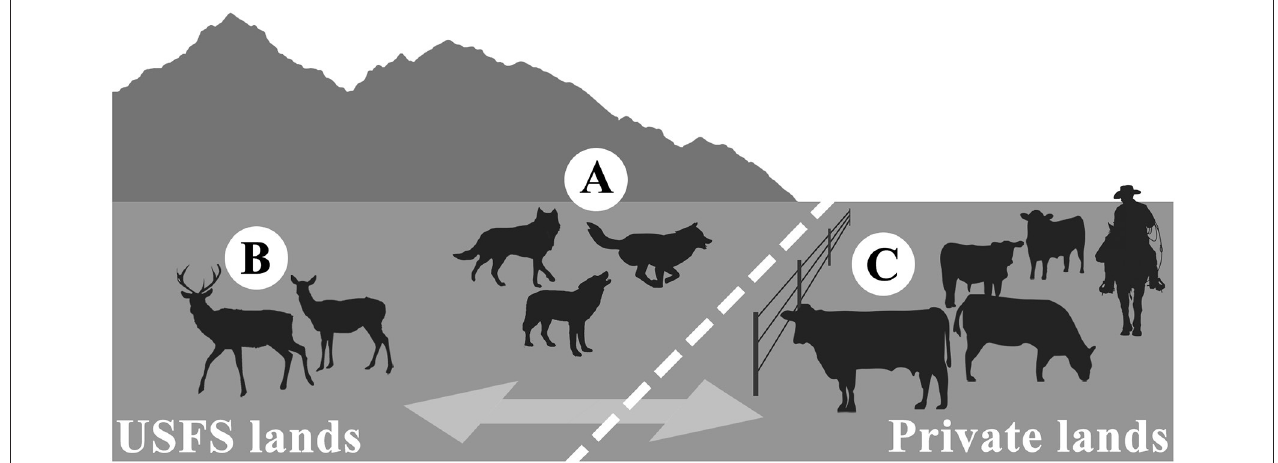
FIGURE 1 | Managing animals across jurisdictions. Livestock producers (“permittees”) graze privately-owned sheep and cattle on private lands as well as seasonally on USFS allotments, where they share space with wildlife. Wolves (A) prey on wild ungulates (deer and elk) (B ) as well as opportunistically on domestic livestock (C) . Wolves are managed by the U.S. Fish and Wildlife Service while under ESA protections, and otherwise by state-level fish and wildlife agencies. State agencies manage public hunting seasons (“harvest”) of wild ungulates and, where allowed by state wolf plans and regulations, wolves. They also authorize USDA APHIS Wildlife Services to deploy nonlethal deterrents in collaboration with livestock operators, as well as carry out lethal control actions for “problem wolves” in response to confirmed depredation